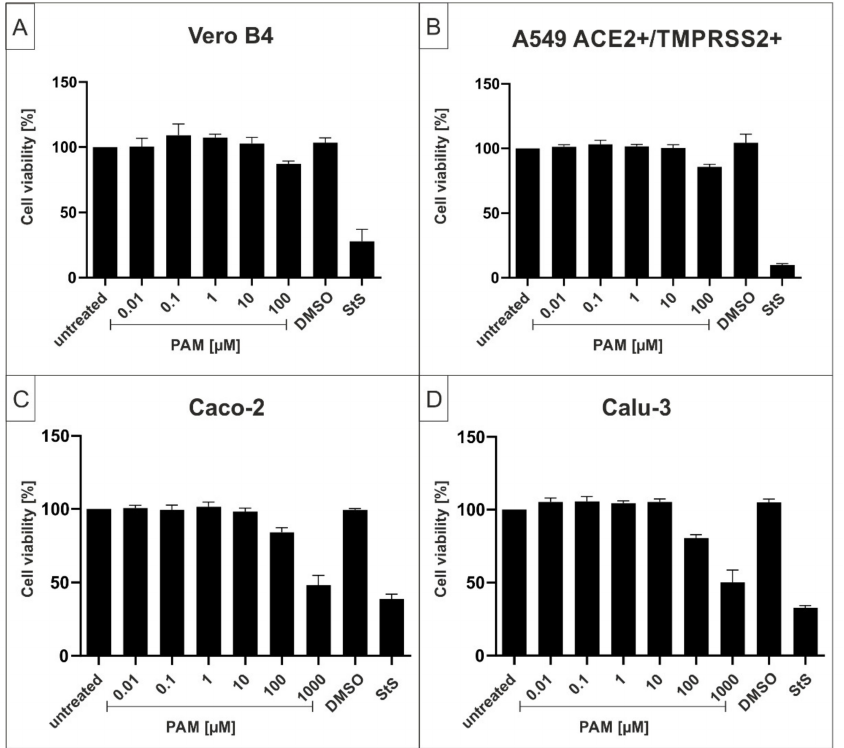
Figure 2. Influence of PAM on the cell viability of Vero B4 ( A ), A549-ACE2+/TMPRSS2+ ( B ), Caco-2 ( C ), and Calu-3 cells ( D ). Following treatment with different concentrations of PAM (PAM concen- trations are indicated at the x -axis) for three days, the influence on cell viability was measured by water-soluble tetrazolium salt (WST)-1 assay. Bars represent means of three independent experiments ± SD. Staurosprine (StS, 1 µ M) was used as a positive control. DMSO as solvent control was added in the same amount as in the highest concentration of PAM (100 µ M ( A , B ); 1000 µ M ( C , D